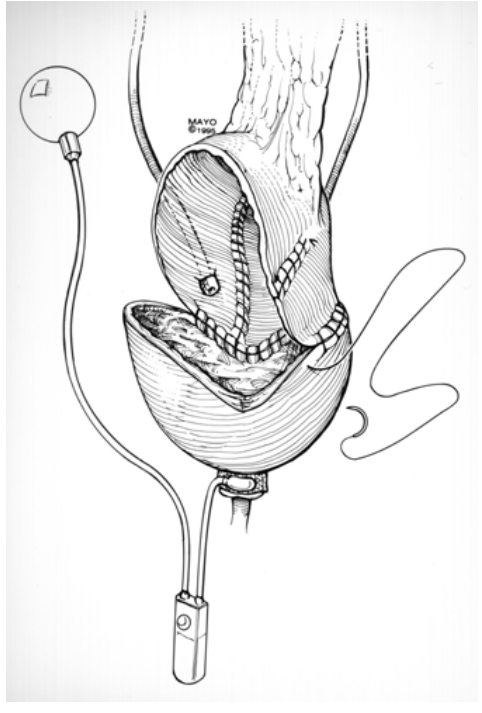
FIGURE 15. Augmentation cystoplasty with simultaneous AUS implantation; bladder open to show